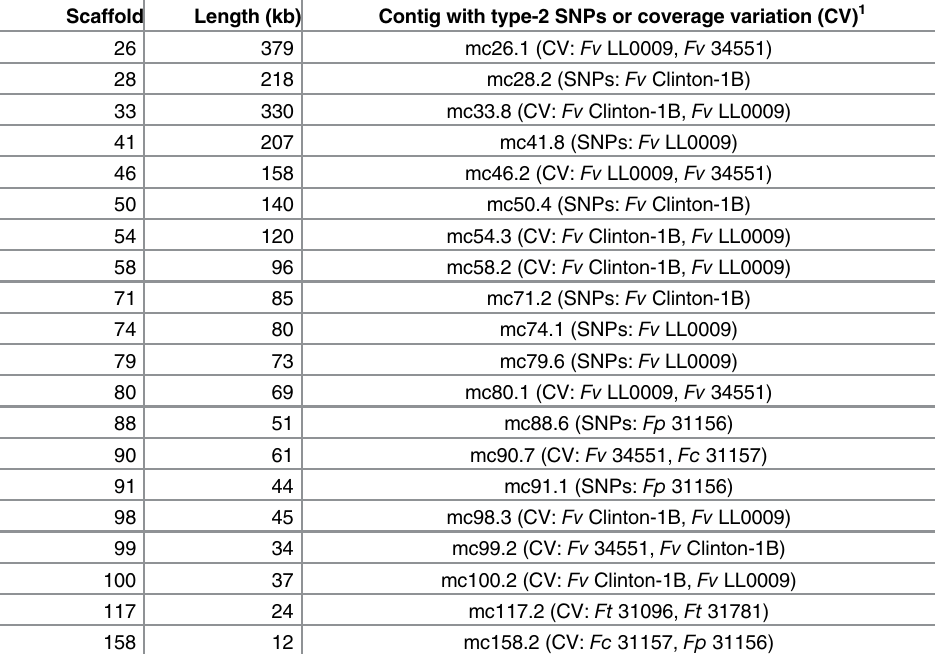
Table 4. Scaffolds with supernumerary segments.